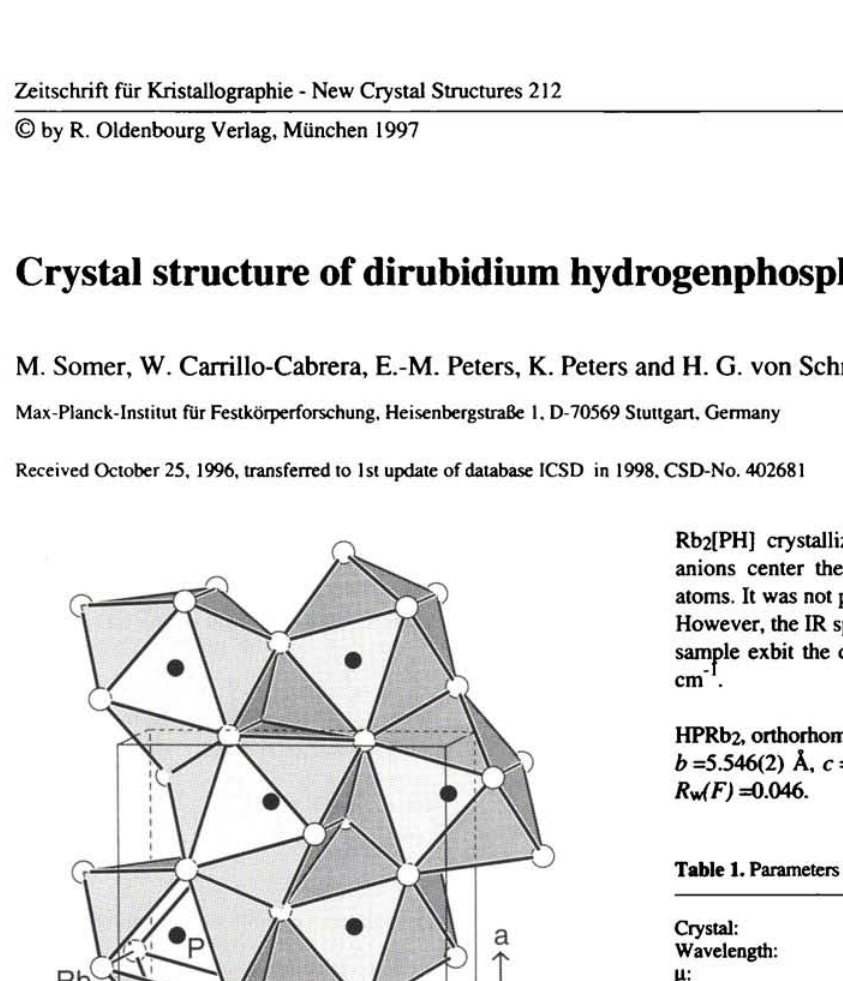
Table 1. Parameters used for the X-ray data collection